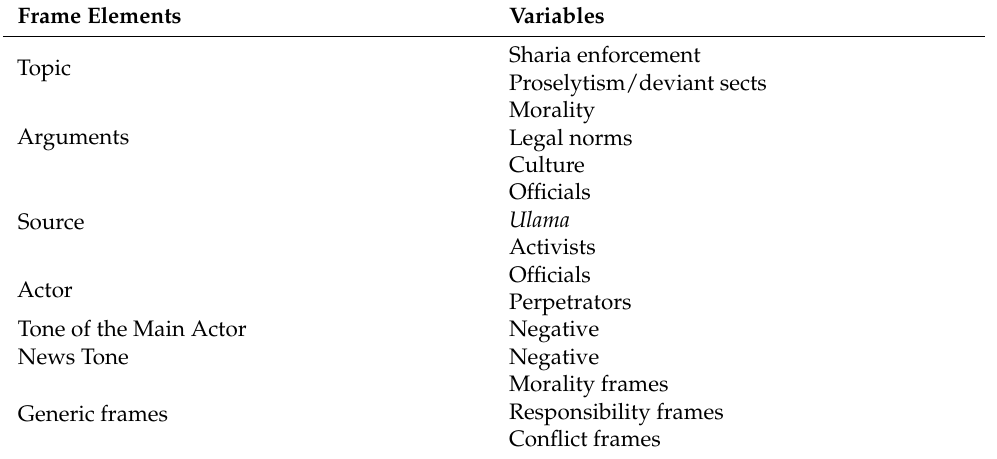
Table 3. The deviance from Sharia frames.